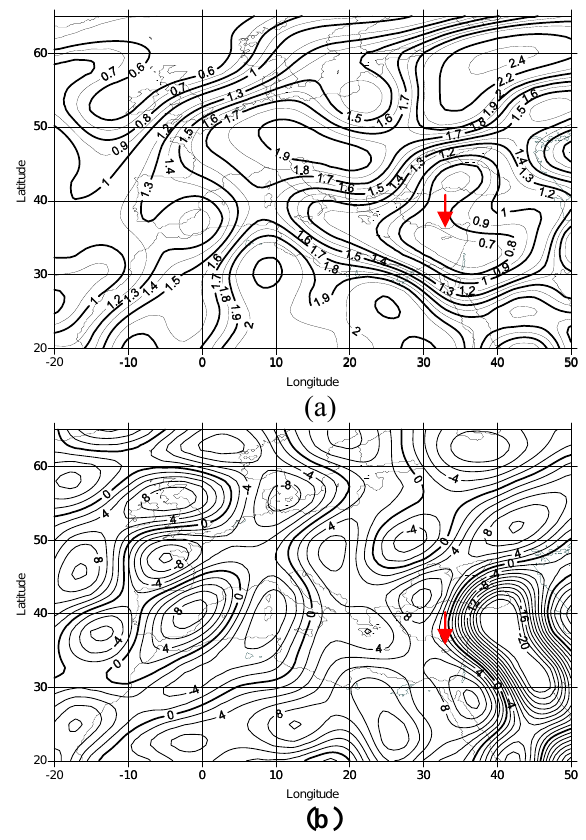
Fig. 10. As Fig. 3, but for 0000 UTC 30 January 2008.